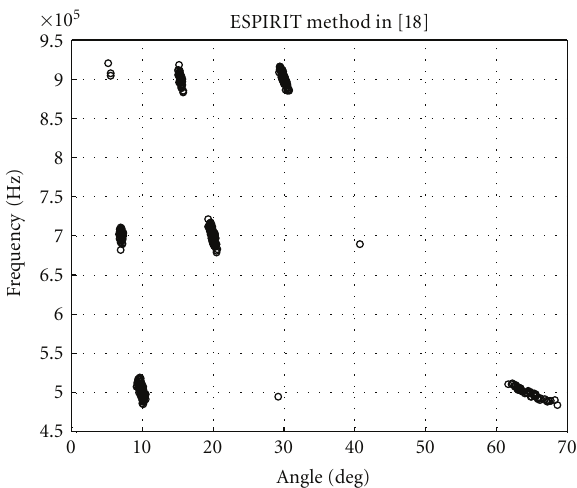
Figure 1: Angle-frequency scatter of the Wang’s ESPRIT algorithm at SNR = 0